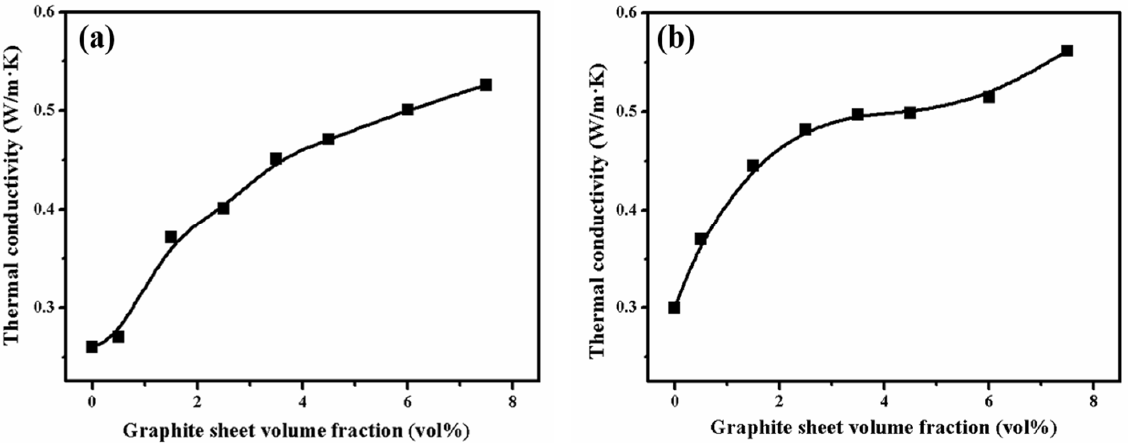
Figure 7. Thermal conductivity of the PA6 -GS composites ( a ) and 80PA6/20PA612-GS composites ( b ) as a function of GS contents.